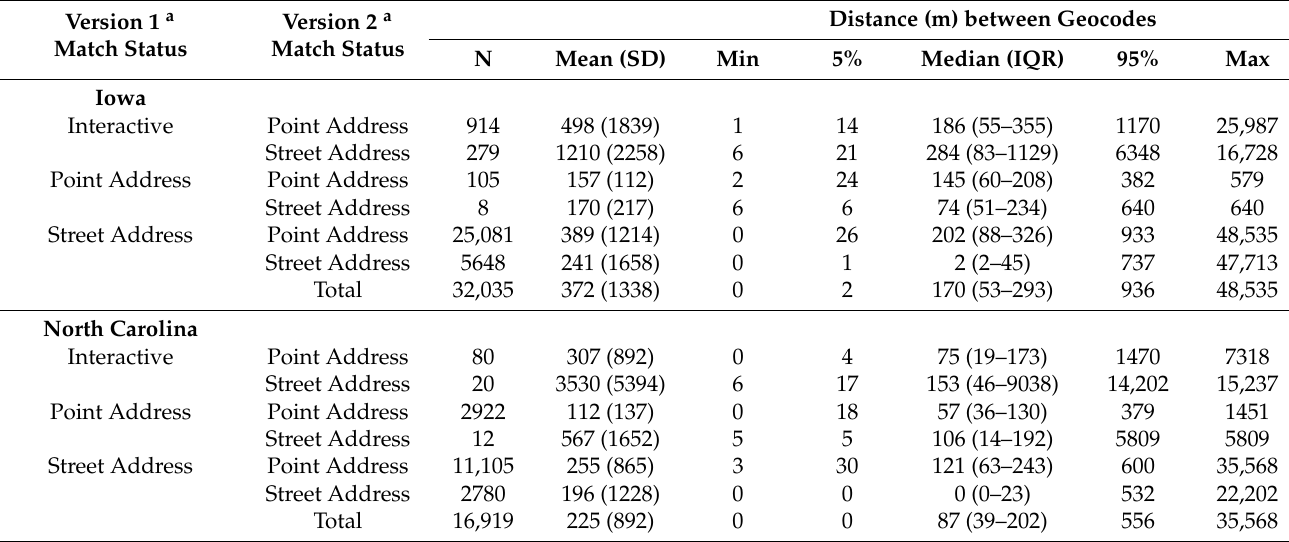
Table 2. Distance between Version 1 and Version 2 geocodes for addresses in Iowa and North Carolina by match status.